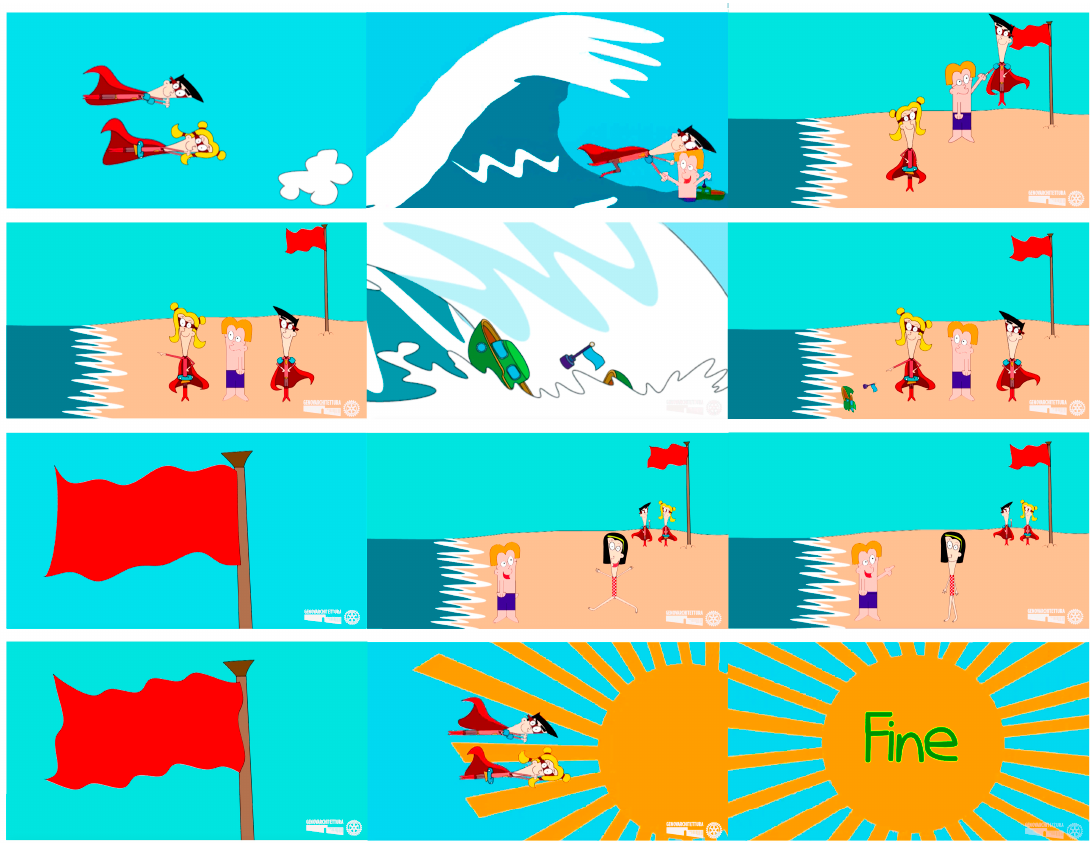
Figure 4. Frames from the project “Superbimbi al mare”. Problem: “sea incident” (inattention to the warning alerts for bathers). Target: children 6–9 years. Technique: animation, duration 1 minunte and 45 s. Visual column: images and texts; series of sequences: “il viaggio verso il mare”, “arrivo al mare e trasformazione dei bimbi in Superbimbi”, “il salvataggio e l’insegnamento”, “finale”. Soundtrack: music and ambience sounds. Authors: X. Ferrari, M. Ferri, M. Pagano, R. Posadino. Credits in note 3